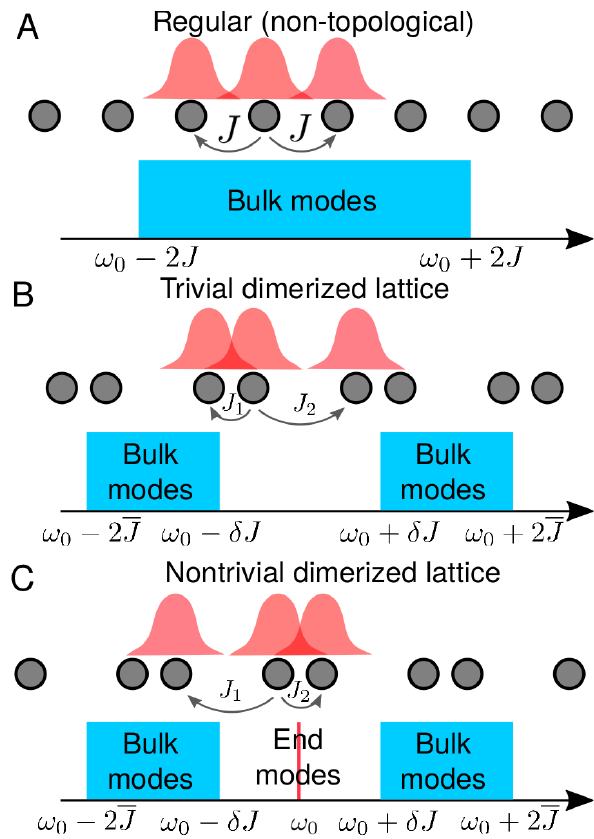
Figure 1: Schematic of the general procedure for creating a topological medium. (A) A regular periodic lattice can be modelled as a collection of resonant elements (shadedcircles) with individual resonant frequencies ω 0 coupled together to form a band of delocalized bulk modes. The coupling strength J is determined by the overlap between the modes of the individual lattice sites, sketched in red. (B and C) Reducing the translation symmetry of the lattice by introducing staggered couplings J 1 ≠ J 2 opens a minigap in ( J + J ) . the bulk spectrum of size 2 δ J , where δ J (cid:1) | J 1 − J 2 | and ¯ J (cid:1) 1 1 2 2 (B)The trivial dimerizedlattice J 1 > J 2 hoststwo bandscorresponding to symmetric and antisymmetric dimer modes, separated by a minigap. (C) In the nontrivial dimerized lattice J 1 < J 2 , the dimers at theendsarebroken,producingmid-gapmodeslocalizedtotheends of the or by perturbing honeycomb lattices. The synthetic gauge fi eld refers to complex (direction-dependent) coupling between different sites of the photonic lattice, arising in systems with nonreciprocity or broken time-reversal sym- metry, corresponding to tight binding coupling terms of the (cid:1) a (cid:1) a + Je − i θ (cid:1) a † θ is the coupling phase. form Je i θ (cid:1) a † n + n n + 1 , where n 1 Complex coupling is formally equivalent to the effect of an electromagnetic vector potential on electron transport. Using a suitable position-dependent synthetic gauge fi eld θ = θ ( x , y ) allows one to create an effective magnetic fi eld for light [28], resulting in analogues of the quantum Hall to- pological phase [15].